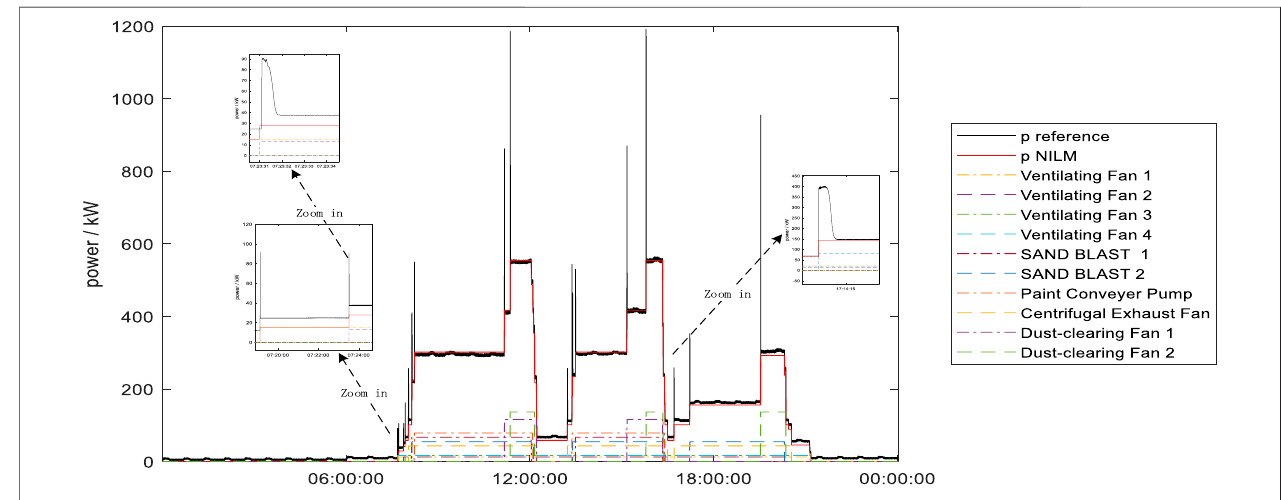
FIGURE 11 | Motor load identi fi cation